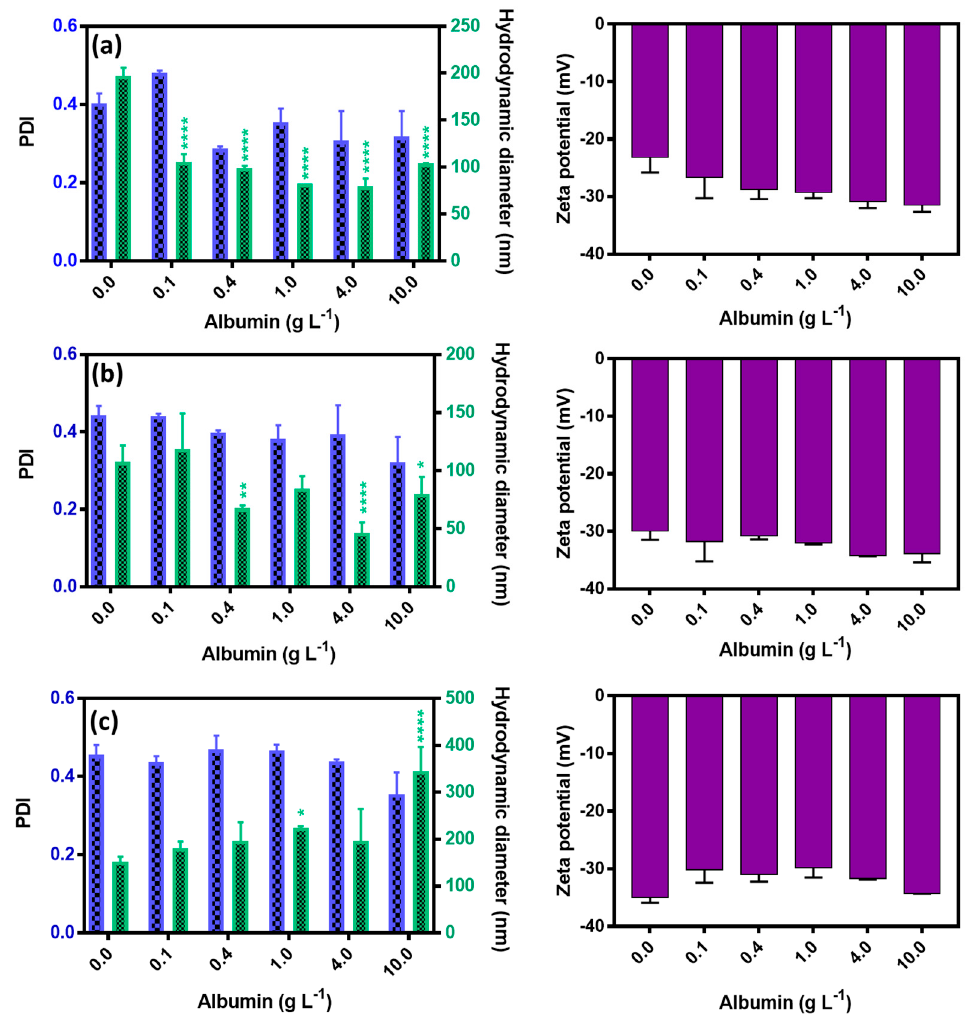
Figure 3. Influence of increased concentrations of albumin on the physicochemical data of ( a ) Fe 3 O 4 NPs, ( b ) Fe 3 O 4 @Ag NPs, and ( c ) Fe 3 O 4 @Ag/TCS NPs. Results show the values of hydrodynamic diameter (nm), measured in percentage of number, polydispersity index (PDI), and zeta potential (mV). * p < 0.0360, ** p < 0.0024, and **** p < 0.0001, calculated using two-way ANOVA. concentrations of Fe 3 O 4 , Fe 3 O 4 @Ag, and Fe 3 O 4 @Ag/TCS NPs (Figure 4). NPs